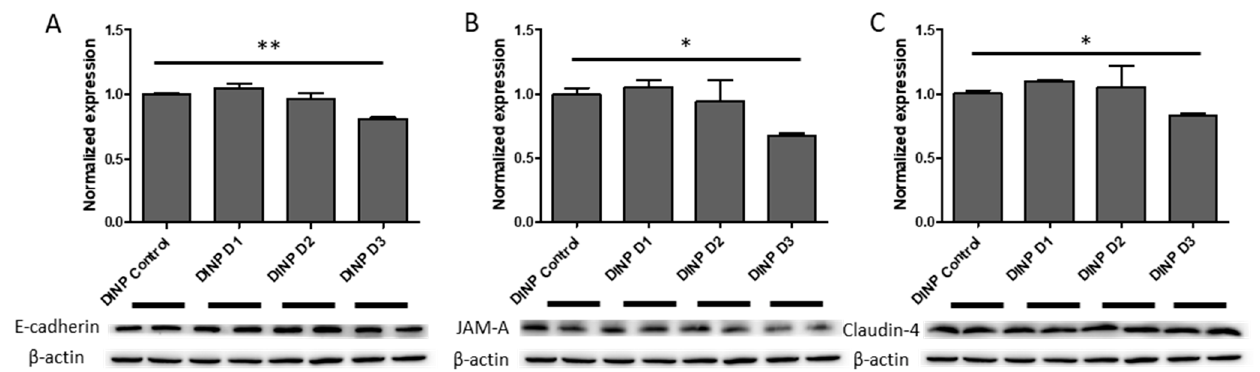
Figure 8. Expressions of ( A ) E-cadherin, ( B ) JAM-A and ( C ) Claudin-4 in HT-29 after luminal extract treatments. Expression levels of protein in cells treated with luminal extracts from no plasticizer fermenter were normalized as 1. The data were produced in triplicate and t-test was used for statistical analysis. * p < 0.05, and ** p < 0.01.